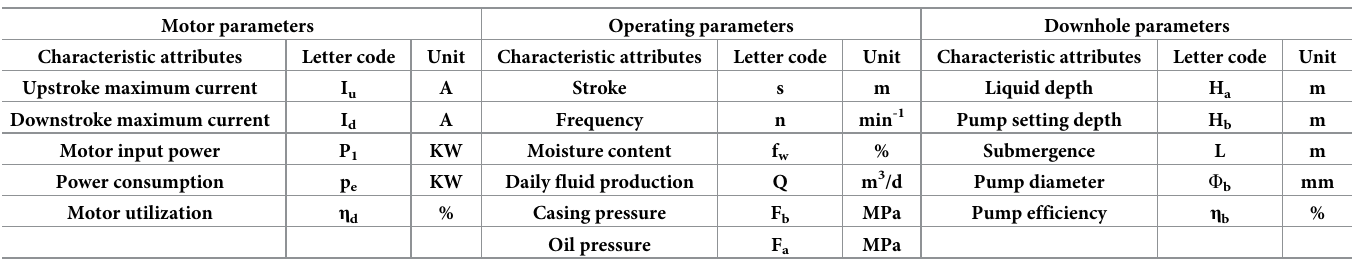
Table 1. Selection parameters for block system efficiency research.